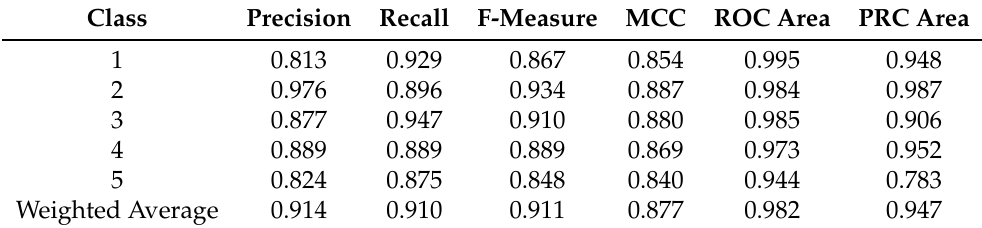
Table 10. NB accuracy